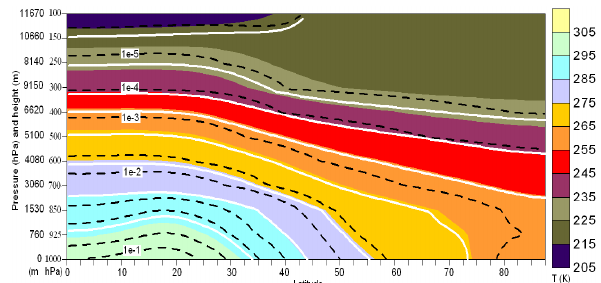
Fig. 1. Vertical profile of zonally averaged air temperature (color- contoured) over Eurasia (0–140 ◦ E) from 1950 through 1980. White solid line indicates the temperature-dependent first order degradation rate of γ -HCH and black dashed line stands for vapour pressure of γ -HCH (log P =11.98–3905/T, Xiao, et al., 2004). The change in degradation rate constant is determined by temperature fluctuation and OH radical concentration, defined as K e = K v · [OH] · 1.0 × 10 6 · exp[( 1 E/R) · (1/ T v − 1 /T e ) ] , where K e is the modified reaction (degradation) rate, K v is the reference degradation rate constant (m 3 mol − 1 s − 1 ), OH is the concentra- tion of hydroxyl radicals in air (= 17 × 10 5 moleculescm − 3 av- eraged over the Northern Hemisphere using values collected by Toose et al. (2004) which is higher than Spivakovsky et al’s value (11 × 10 5 moleculescm − 3 , 2000), 1 E is the activation energy (Jmol − 1 , Table 1), R is the gas law constant (Jmol − 1 K − 1 ), and T e and T v are ambient and reference temperature, respectively. On y-axis the vertical height (m) corresponds to pressures, calculated using the constant air density ρ and the hydrostatic relationship dp/dz =- ρg , where g is the acceleration due to gravity.